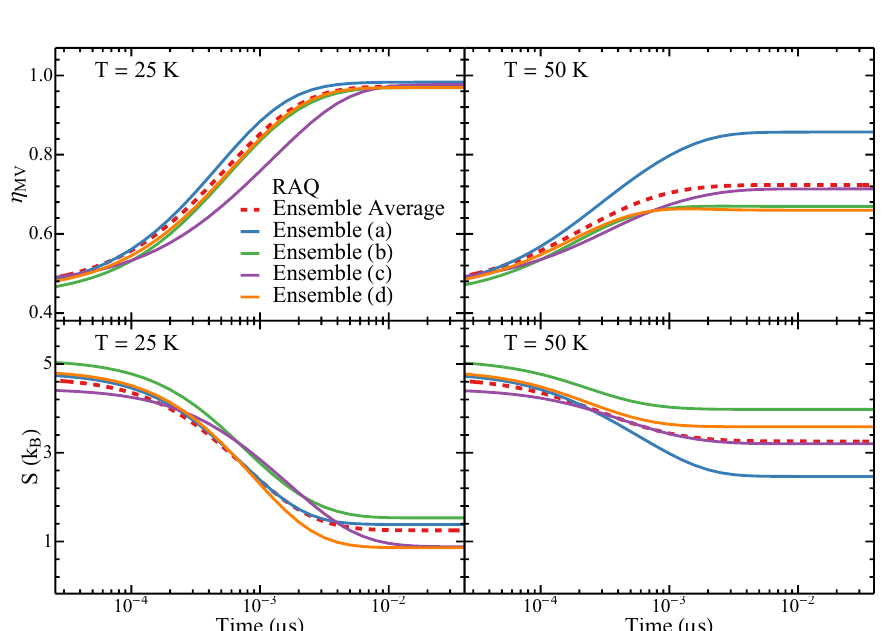
Figure 4. Time dependence of the microvortex (MV) order parameter η MV and the configurational entropy S of the WDSL ensembles illustrated in Figure 1 (solid curves) following a relaxation after quenching (RAQ). The corresponding averages over 100 different realizations of the nanostructures are given by the dashed curves. The simulation temperatures T are